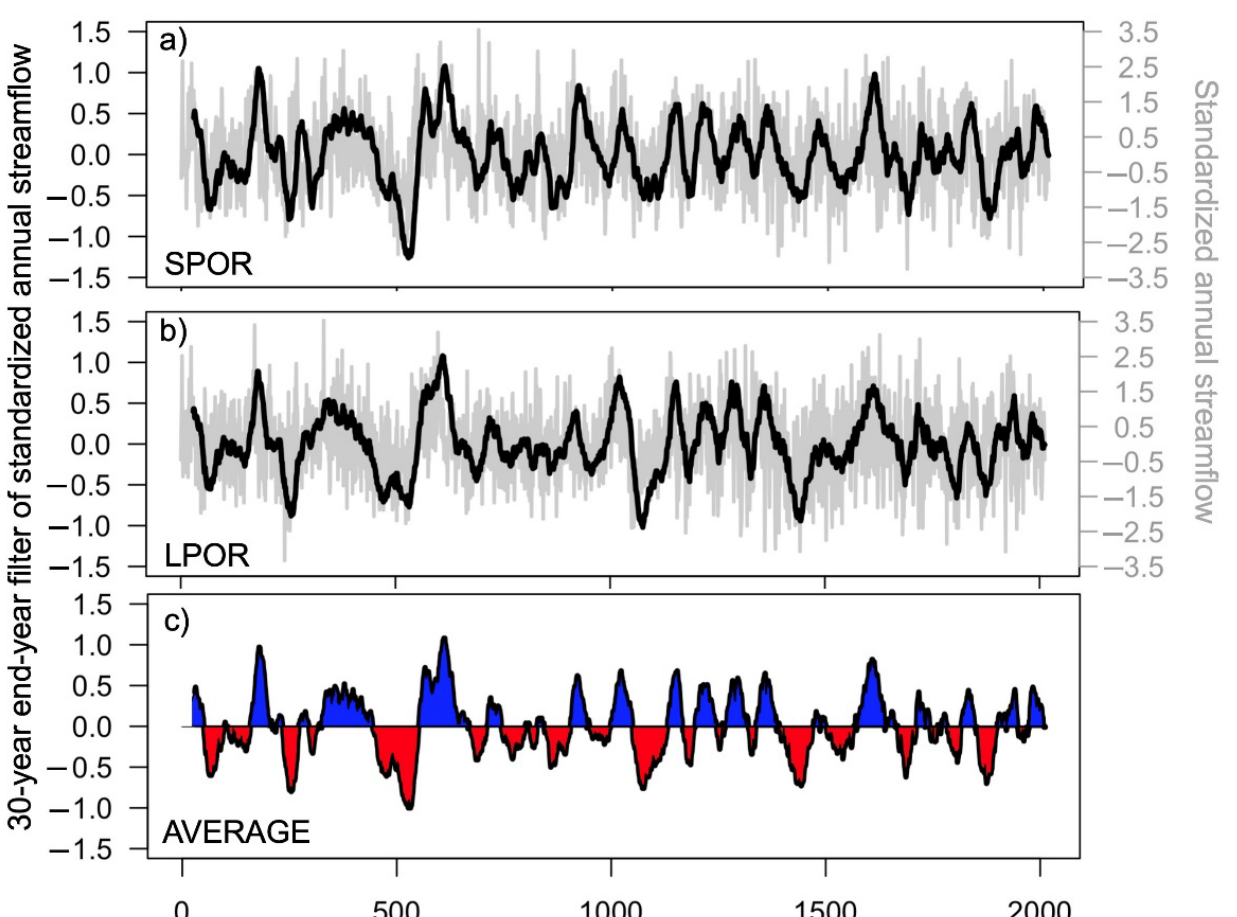
Figure 4. Standardized annual streamflow reconstructions for ( a ) SPOR, ( b ) LPOR, and ( c ) SPOR and LPRO average. The black line represents the 30-year end-year-filtered streamflow, while the gray lines in ( a , b ) represent annual flows.